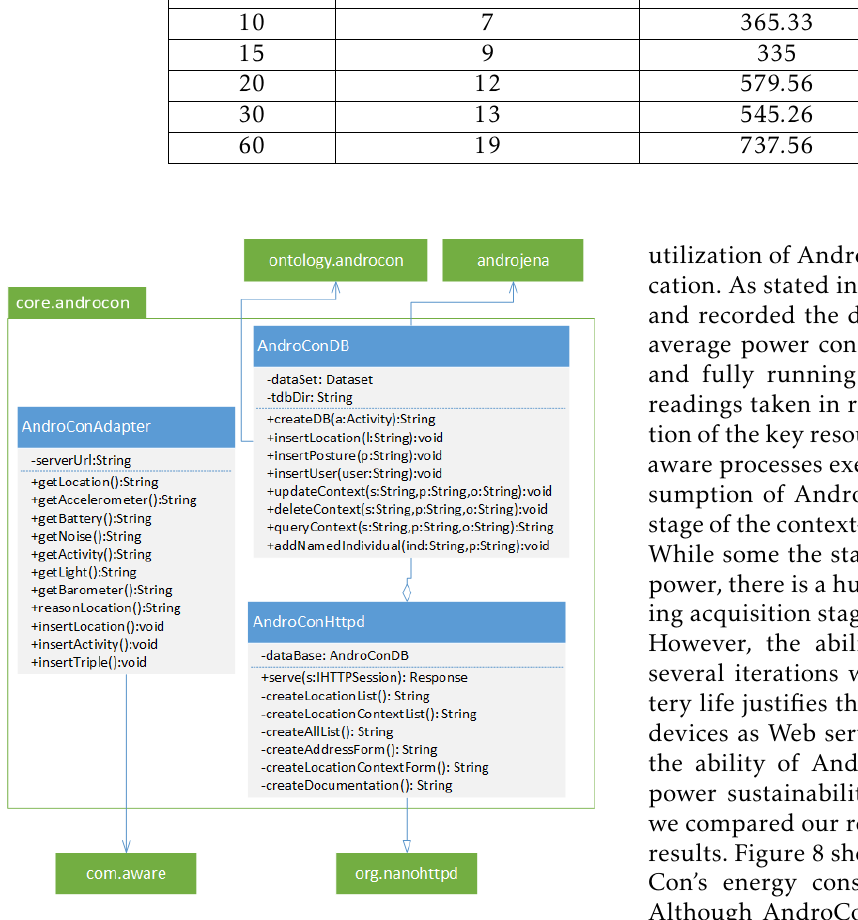
Figure 6. AndroCon Class Diagram